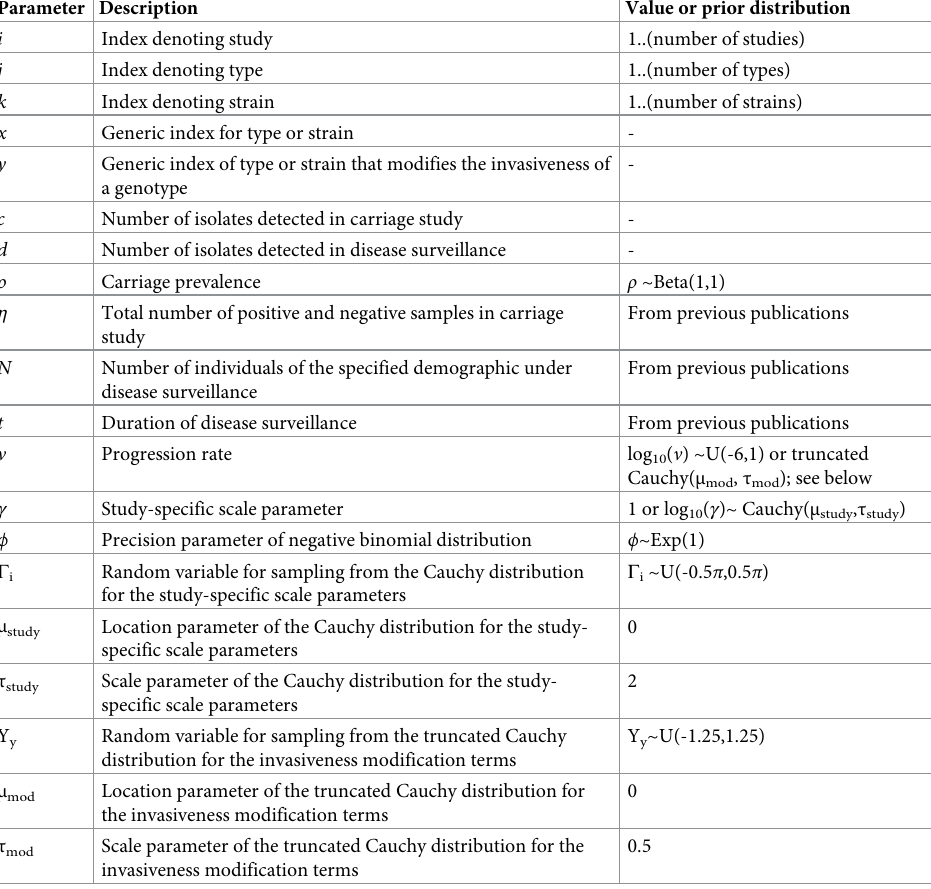
Table 1. Summary of parameters used in the